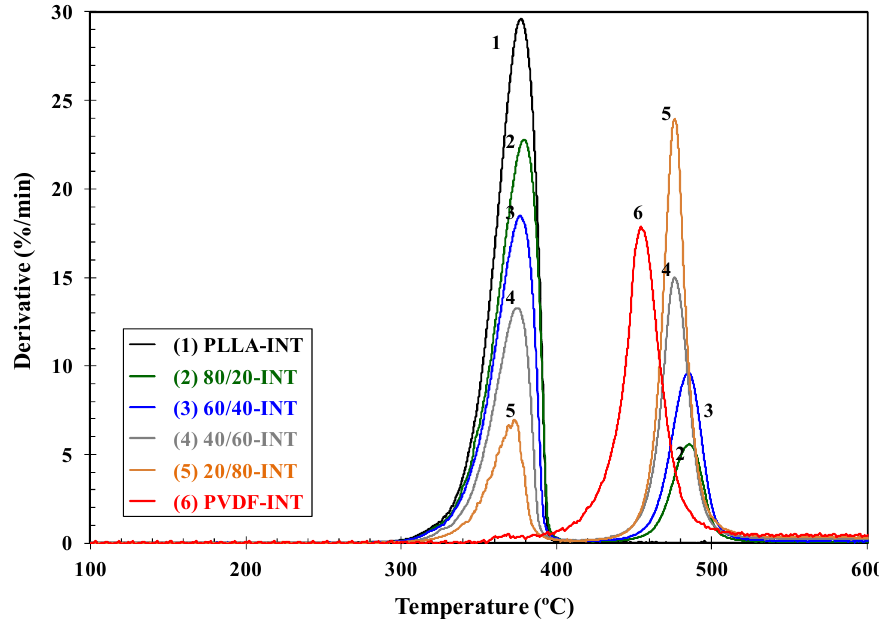
Figure 5. DTG curves of PLLA/PVDF/INT-WS 2 nanocomposites. Table 1. TGA parameters of different PLLA/PVDF/INT-WS 2 blend nanocomposites based on PLLA, PVDF, and INT-WS 2 .